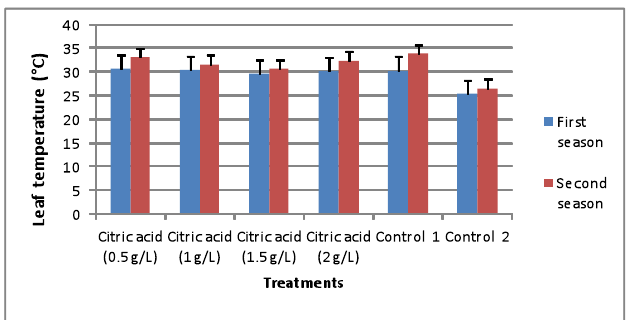
Fig. 1: Effect of different levels of citric acid on leaf temperature of bean plants subjected to drought stress conditions .Control 1: plants not treated by citric acid, but stressed. Control 2: plants not treated by citric acid and kept at field capacity during the entire experiments. Vertical bars present LSD value at 5%.